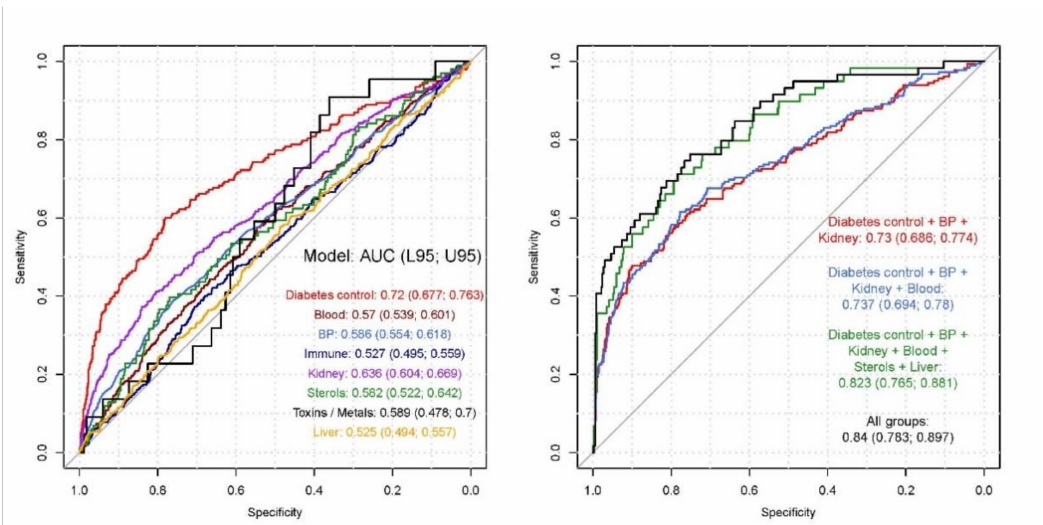
Figure 3. Final clinical risk models. Features from RandomForest ™ were grouped logically based on similar function or clinical use (Table 4) and then tested independently in a univariate or multivariate regression model against diabetic retinopathy (DR) outcome. A final risk model including markers of hypertension, hypercholesterolemia, renal, and liver function tests, and haematocrit achieved AUC 0.84